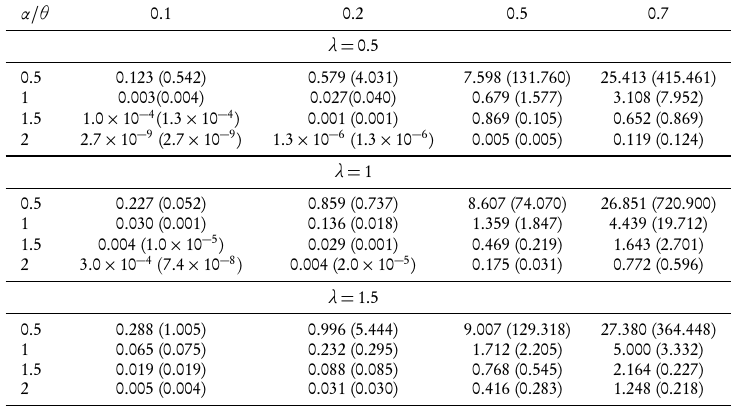
Mean and variance of the DNH distribution for different values of α , λ and θ